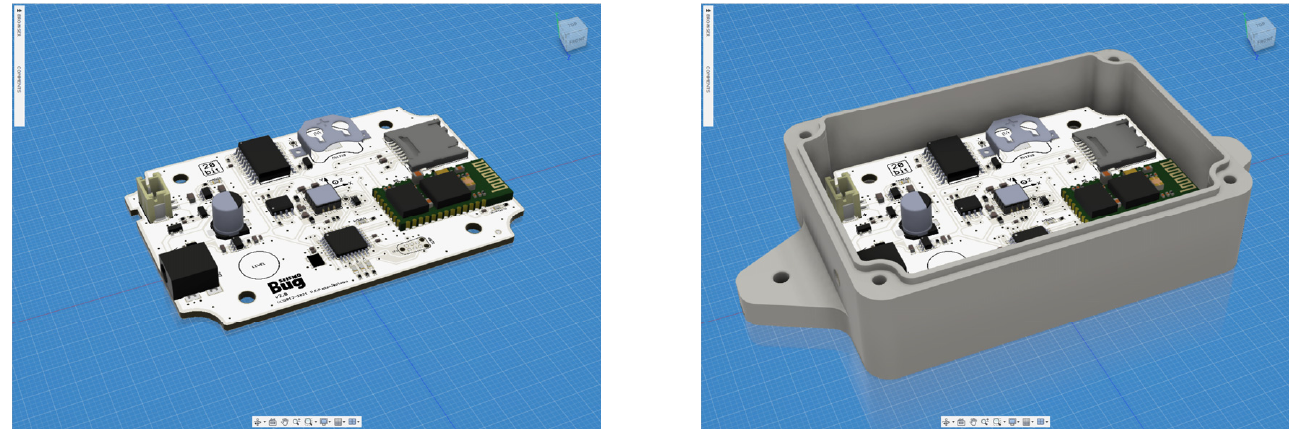
© device under development (photorealistic